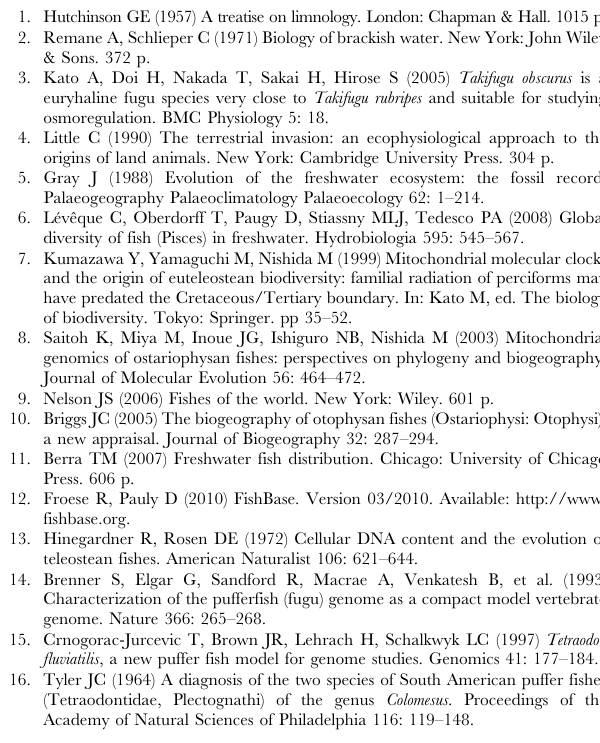
Figure S1 Node numbers on the best-scoring ML tree for showing divergence time estimates in Table S1. (TIF) Table S1 Summary of MCMC samples for node ages (MA) in the independent-rates analyses using MCMCTREE. For node numbers, see Figure